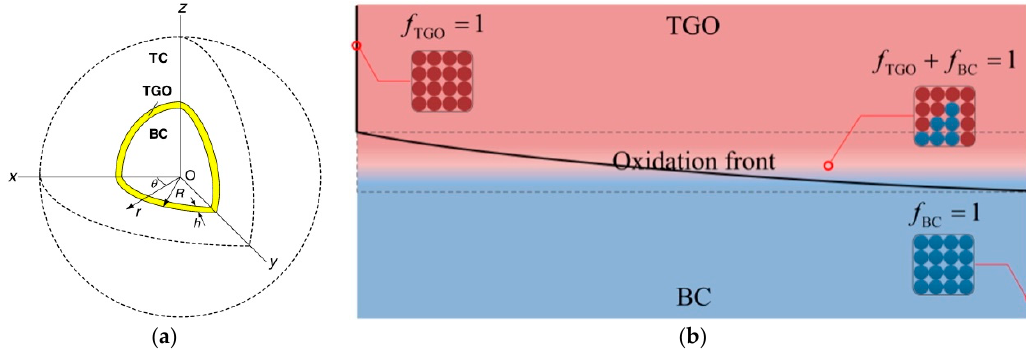
Figure 5. ( a ) The multilayer sphere model of TGO growth [63]; ( b ) the schematic diagram of oxidation front during the TGO growth [64].